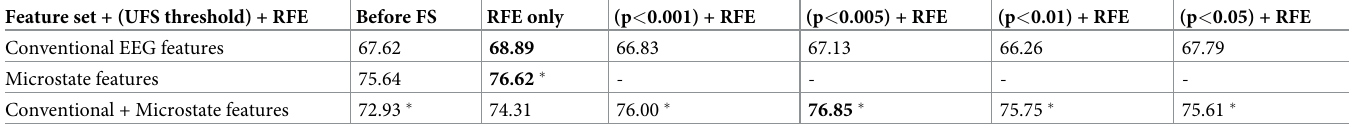
Table 5. Classification accuracies with quadratic SVM classifier achieved for different methods of selecting features from an EEG dataset for patients diagnosed with schizophrenia and healthy (control) subjects. Feature set + (UFS threshold) +